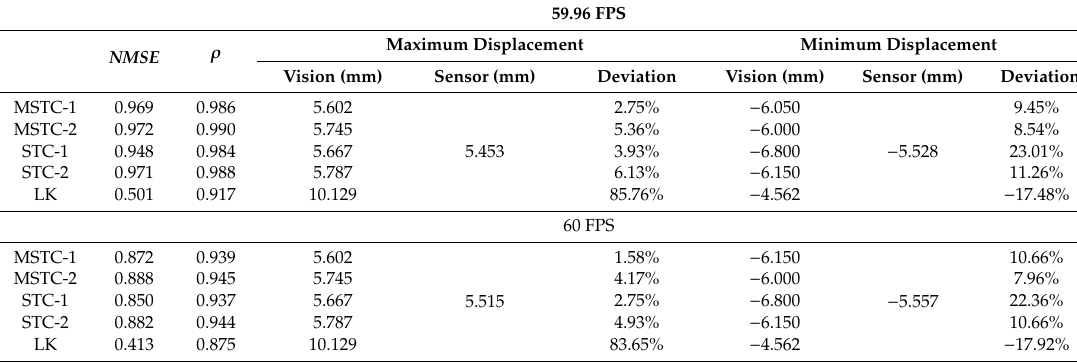
Table 5. Evaluation of displacement monitoring results with fog interference.